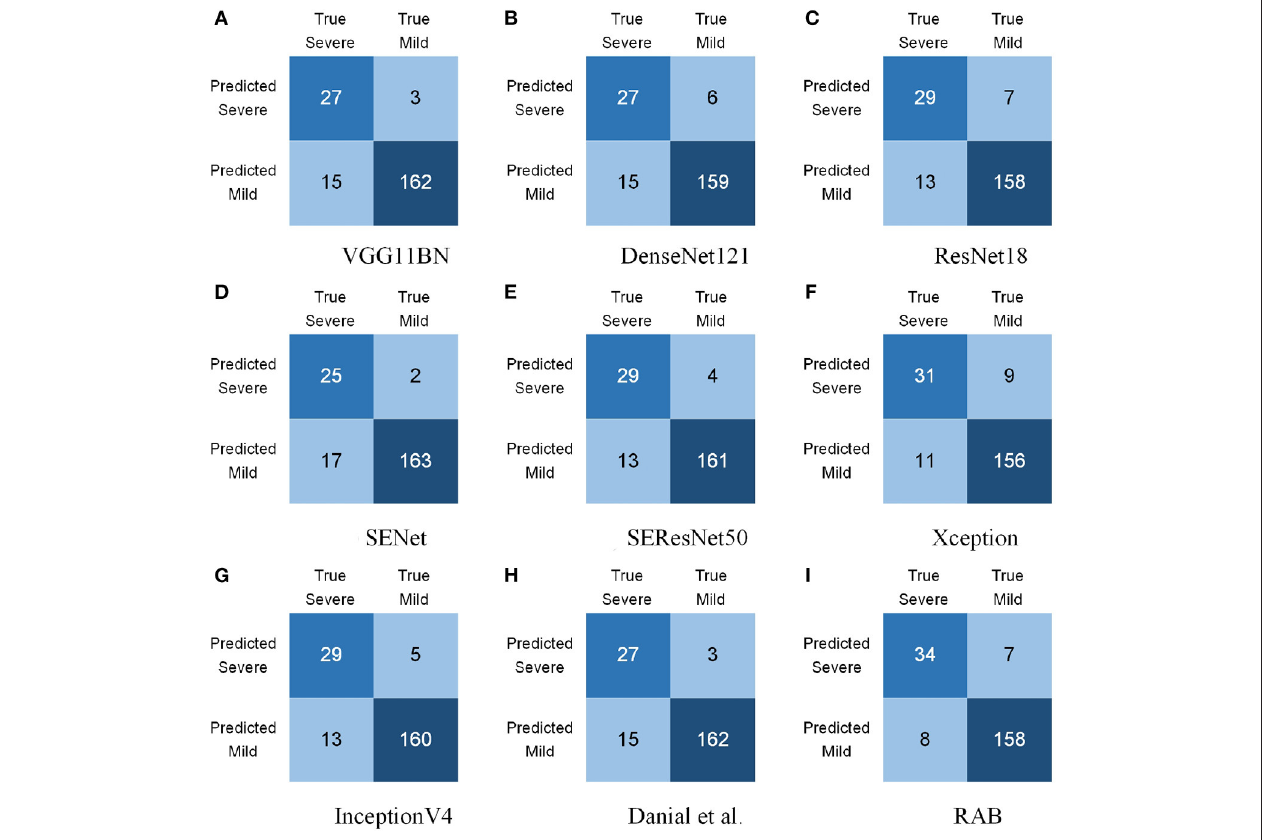
FIGURE 5 | Confuse matrices of severity assessment for COVID-19 patients. (A) VGG11BN (38), (B) DenseNet121 (40), (C) ResNet18 (39), (D) SENet (41), (E) SEResNet ( 41), (F) Xception (42), (G) InceptionV4 (43), (H) Sharifrazi et al. (26) and, (I) RAB